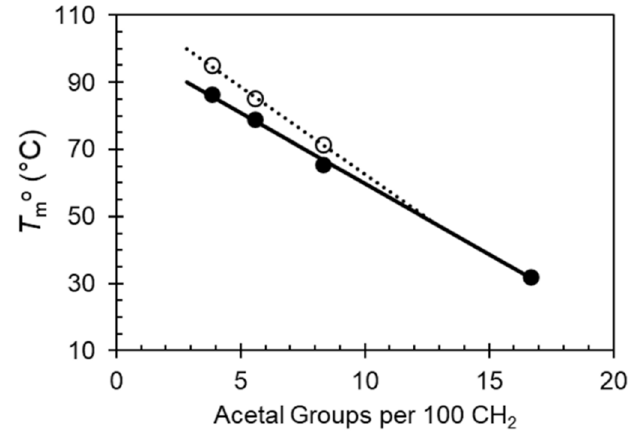
Figure 6. Equilibrium melting temperatures of even-spaced polyacetals plotted versus number of acetal groups per 100 methylene groups in the aliphatic spacer. Open circles are data for Form II and closed circles are data for Form I.